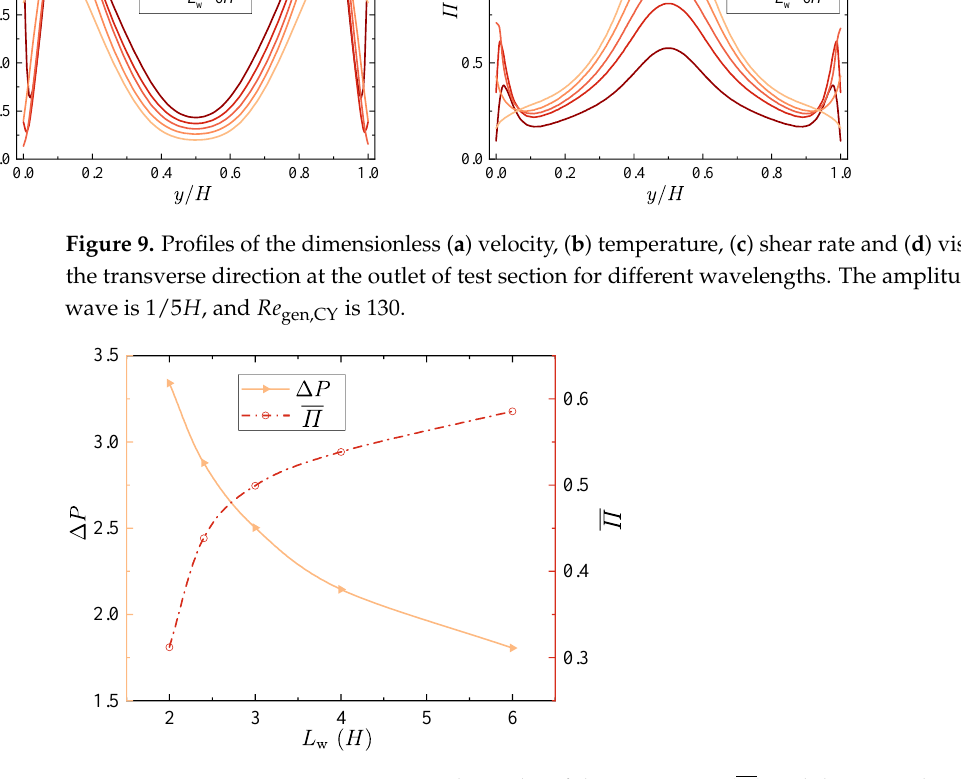
Figure 10. Mean apparent viscosity at the outlet of the test section ( 𝛱̅ ) and dimensionless pressure drop of the test section ( ∆𝑃 ) for different 𝐿 w . The amplitude of the wave is 1/5𝐻 , and 𝑅𝑒 gen,CY is 130.